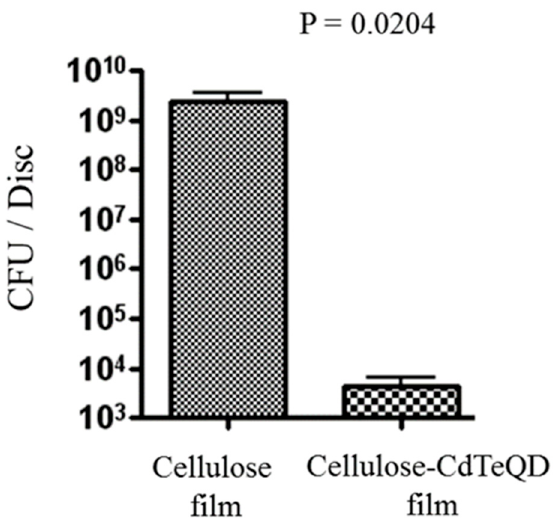
Figure 7. Cellulose-CdTe QDs film significantly reduced biofilm development by S. aureus GFP AH133. Cellulose and cellulose-CdTe QDs films were inoculated with S. aureus GFP AH133 and incubated for